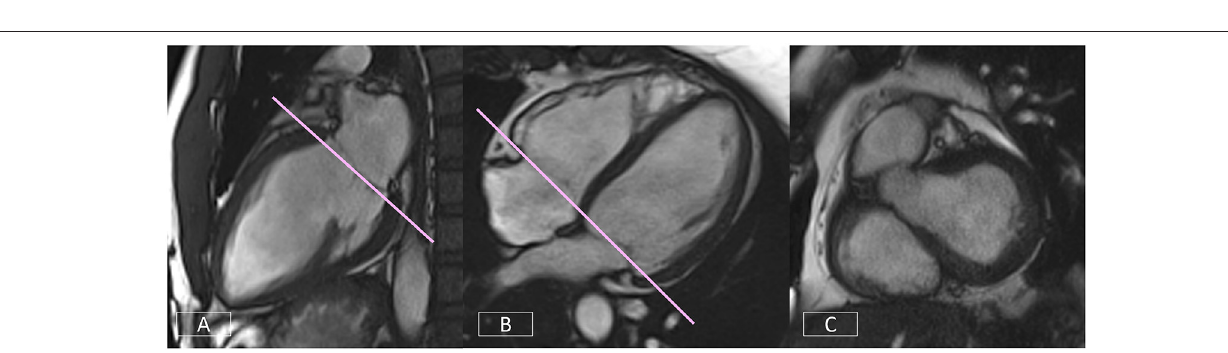
toward the apex ( Figure 10B ). If there is an inconsistent amount of myocardium ( Figure 10C ), the slice angle is tilted on the LV VLA view ( Figure 10D